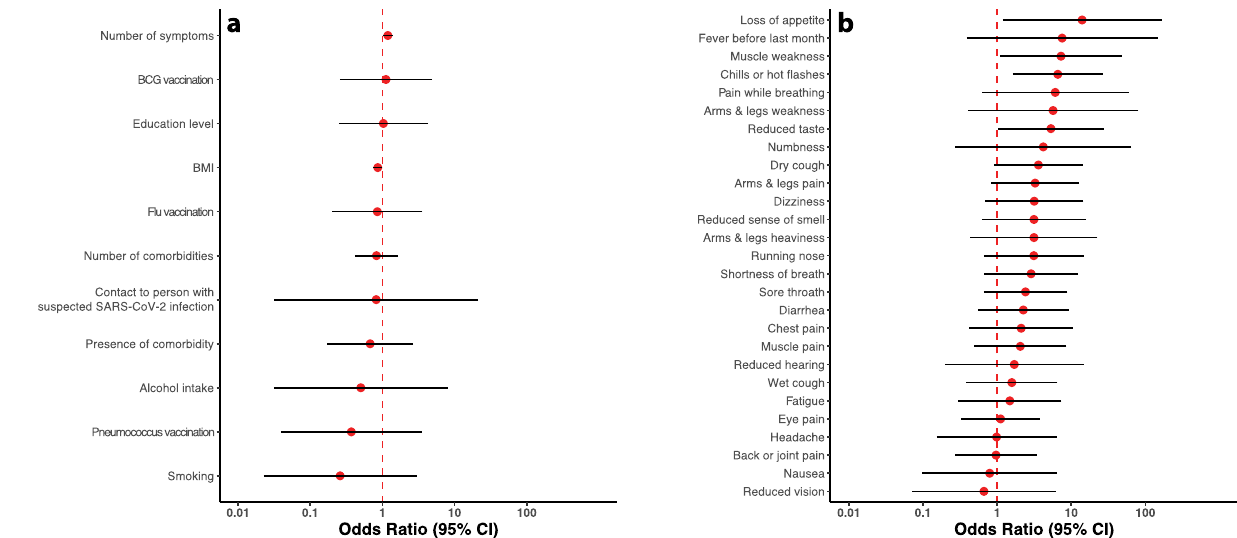
Fig. 4 Factors differentiating between ELISA + individuals with and without neutralizing antibodies. a A higher number of reported symptoms was signi fi cantly associated with a higher odds of having neutralizing antibodies . b Loss of appetite, muscle weakness, chills or hot fl ashes as well as a reduced sense of taste were signi fi cantly more often reported by individuals with versus those without neutralizing antibodies. All estimates are adjusted for age, sex and household clustering. The statistical comparisons were between 16 ELISA + /PRNT + cases and 30 ELISA + /PRNT − control subjects. The red dots represent the odds ratio point estimates, while the whiskers depict the corresponding 95% con fi dence intervals, on a logarithmic